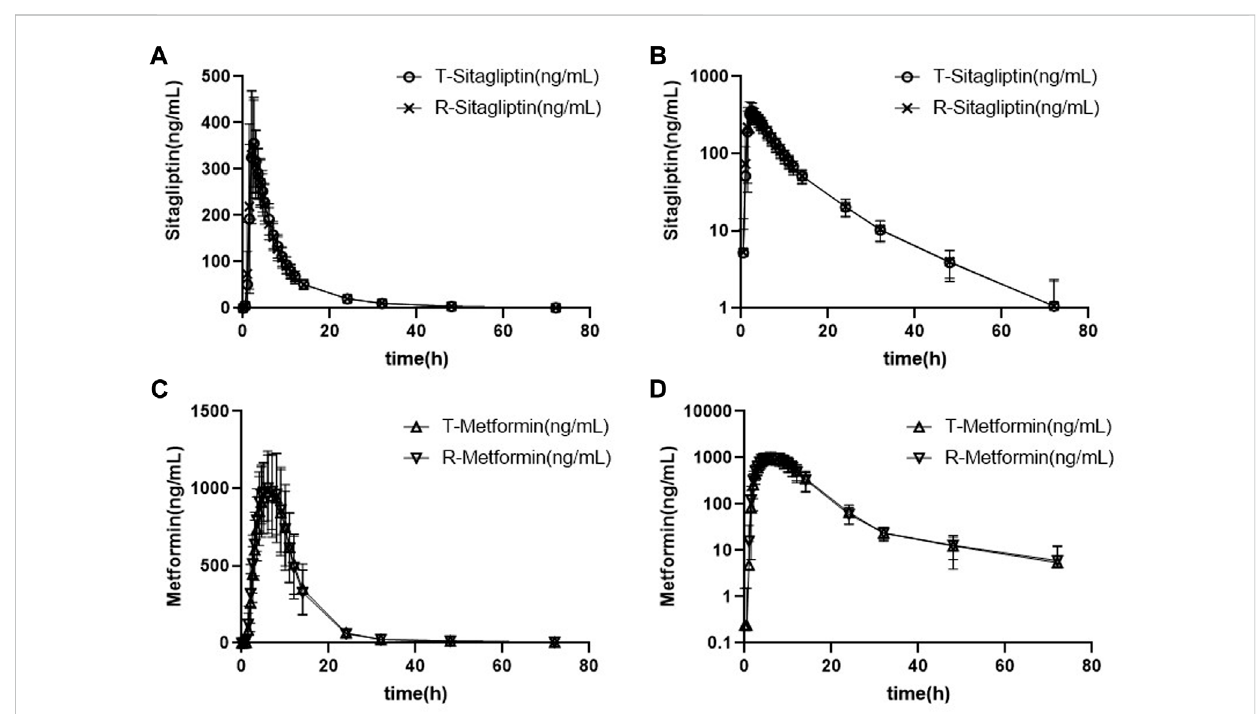
FIGURE 3 Meanplasmasitagliptinandmetforminconcentration-timepro fi lesafterdosingunderthefedstate.Errorbarsrepresentthestandarddeviations. (A) Sitagliptin, linear scale, (B) sitagliptin, semi-log scale, (C) metformin, linear scale, and (D) metformin, semi-log